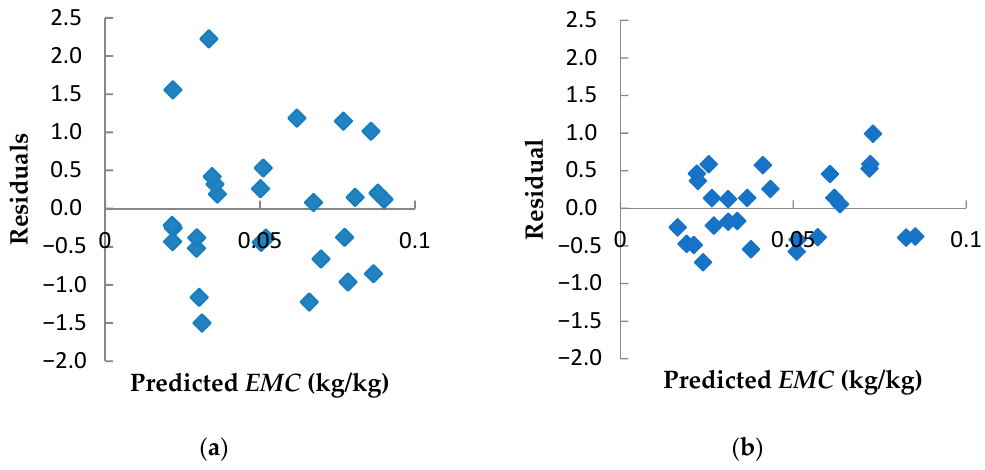
Figure 9. Residuals of predicated EMC for ( a ) whole kernel (modified Oswin model) and ( b ) ground kernel (modified Halsey model).